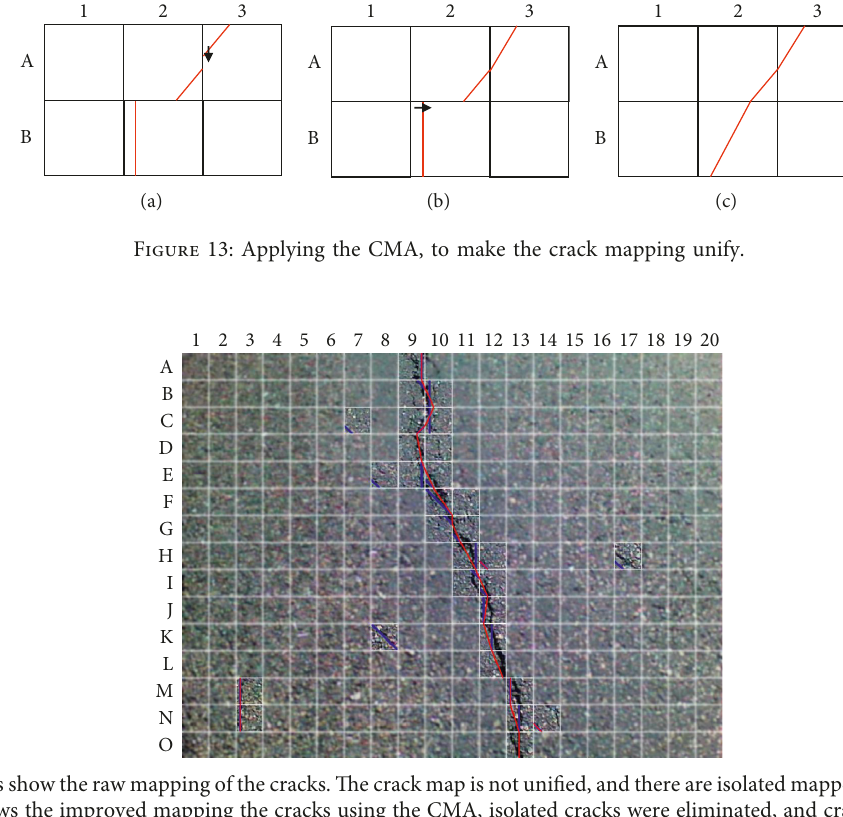
have detected cracks. The CMA begins to map the input image in real time by scanning from row A from left to right.